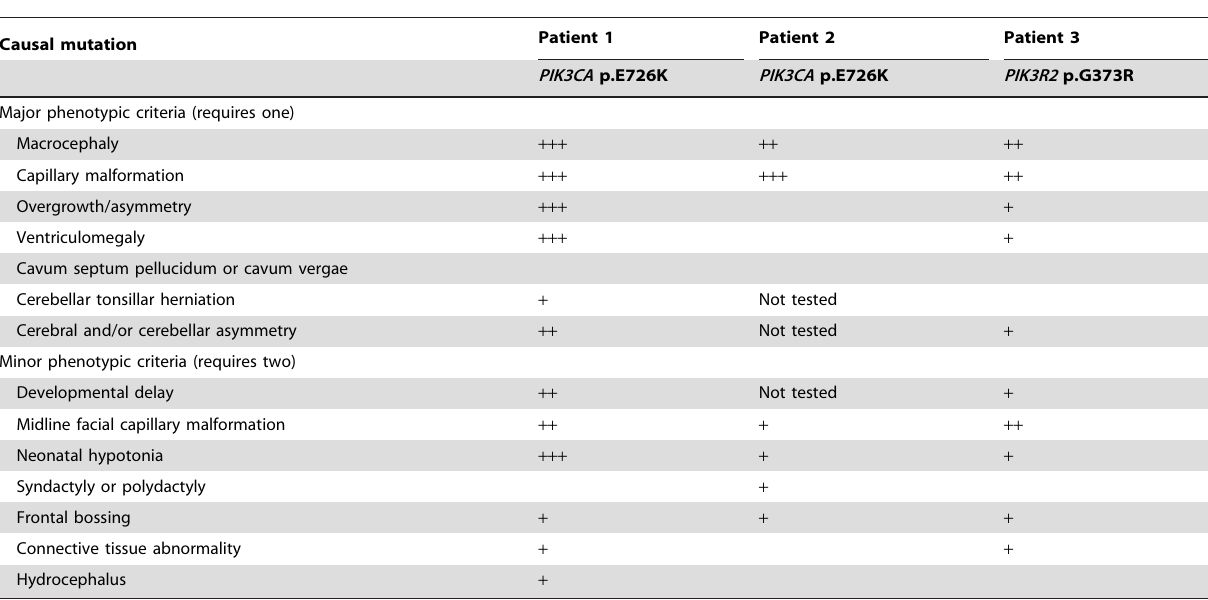
Table 1. Causal genotype and phenotypes in three cases with